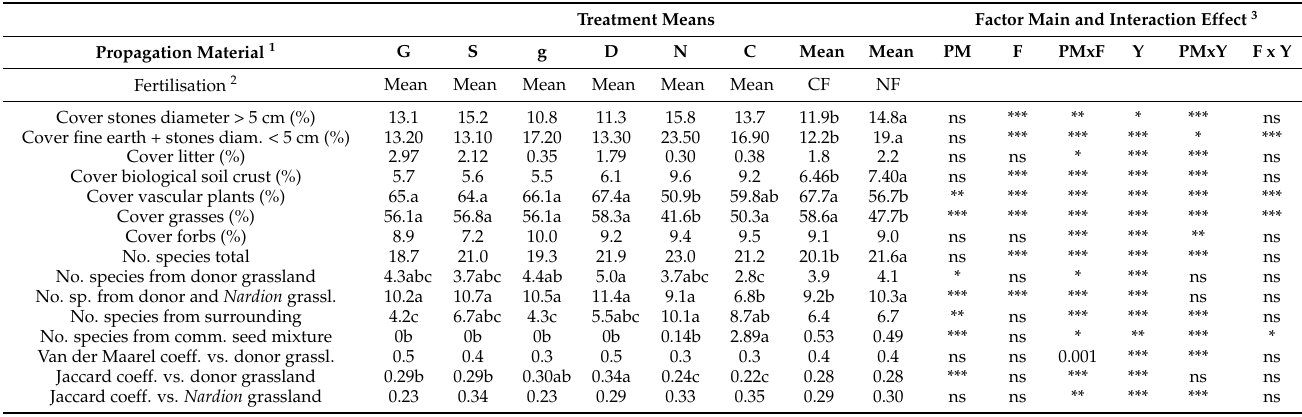
Table 2. Effects of six propagation materials and two fertilisation treatments on the main traits of a ski slope grassland restoration